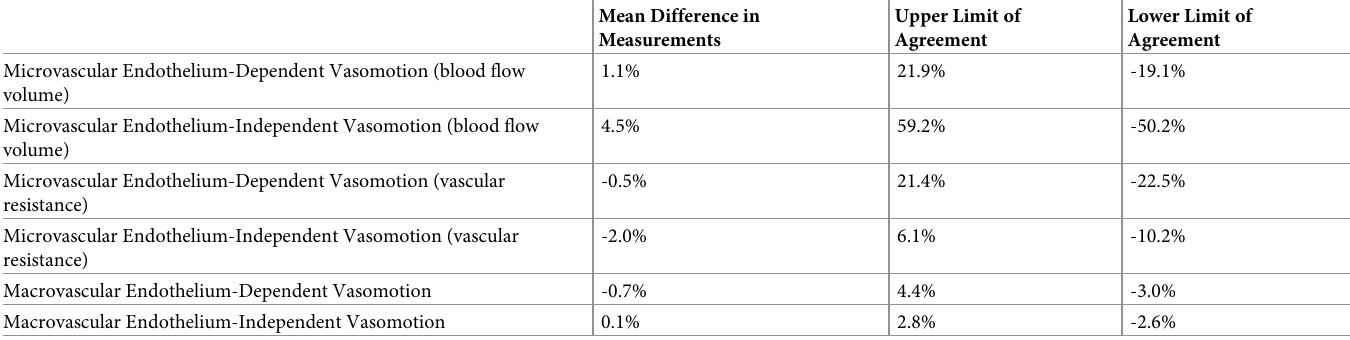
Table 2. Mean differences and limits of agreement for 6-month variability in vasomotor function from Bland-Altman analyses.